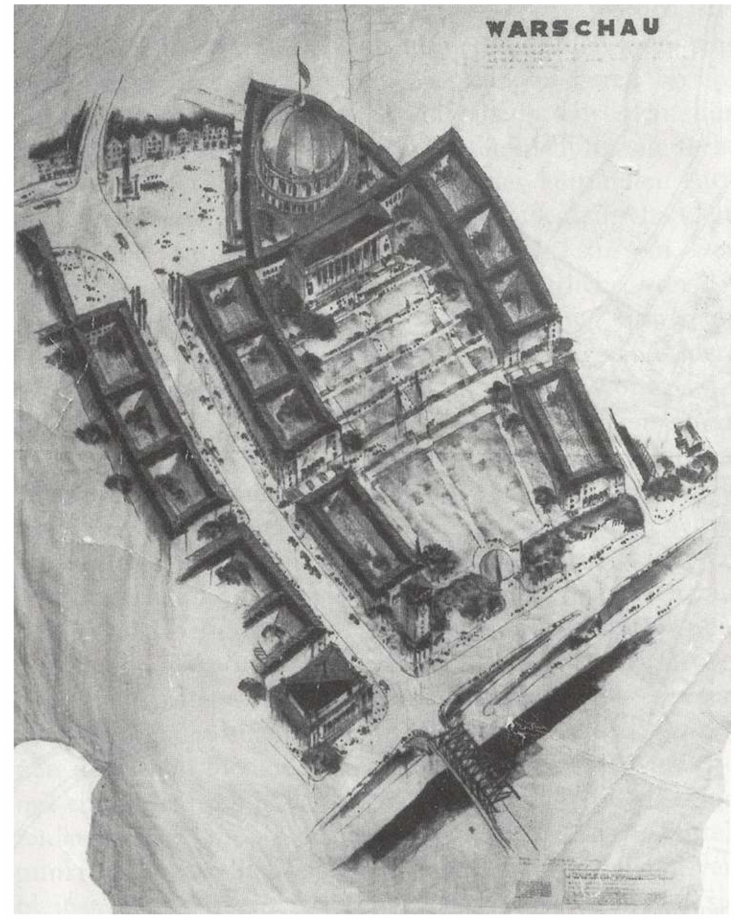
Figure 4. A Nazi German design for the Warschau Volkshalle complex at the annihilated Royal Castle site, 1942 (Hans Hubert Leufgen, public domain) after [24] (plate